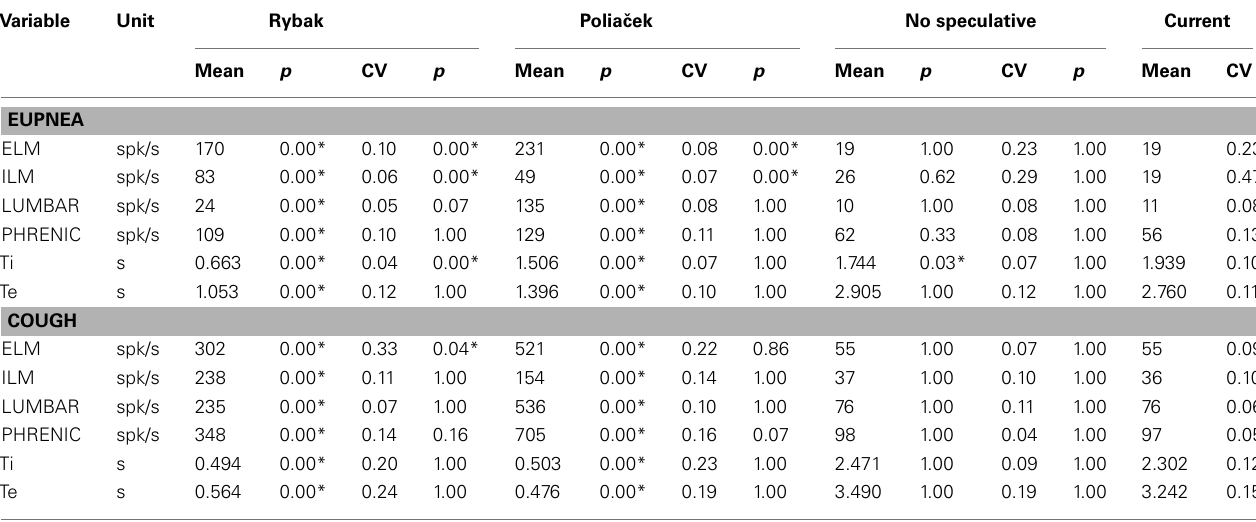
Table 5 | Comparison with previous